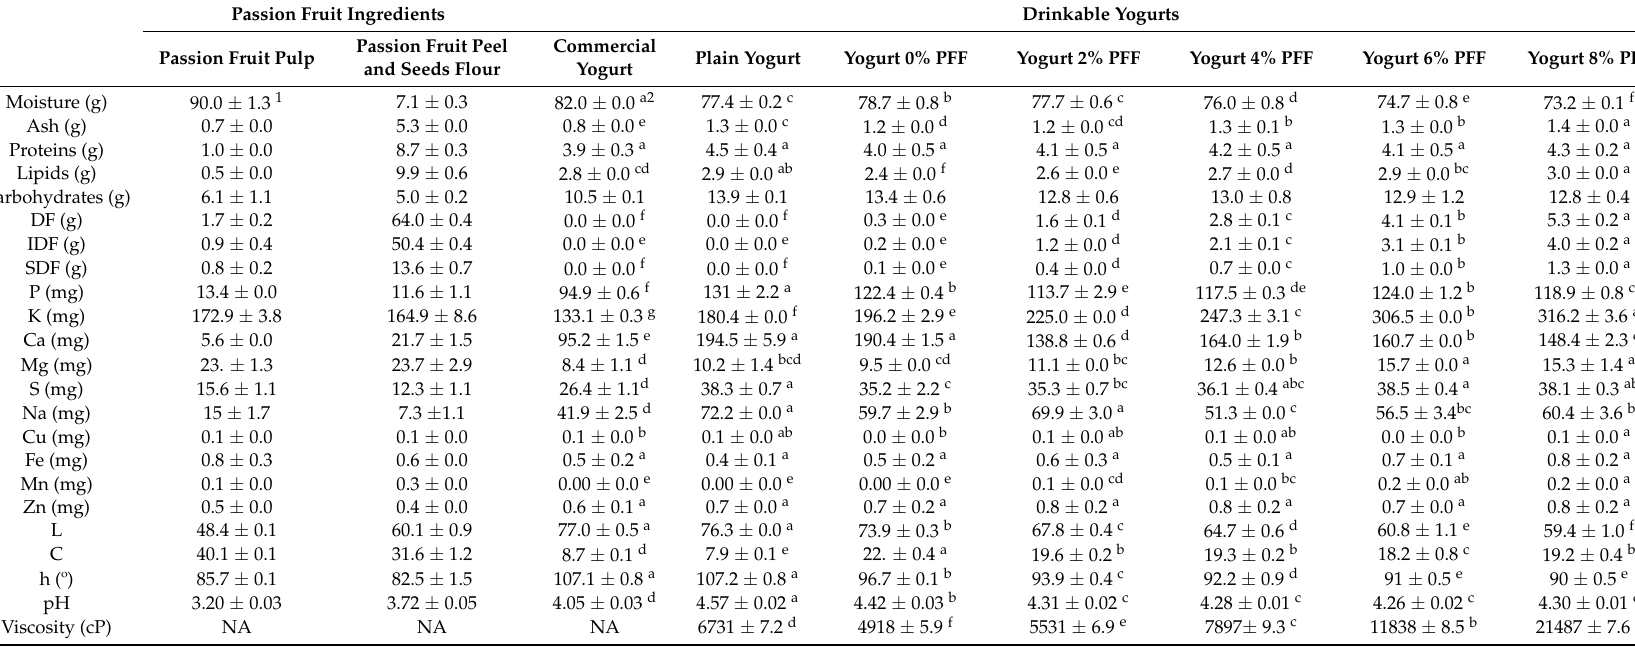
Table 1. Proximate composition, mineral content, color (L, C, and h), pH and viscosity parameters of passion fruit ingredients and drinkable yogurts. Passion Fruit